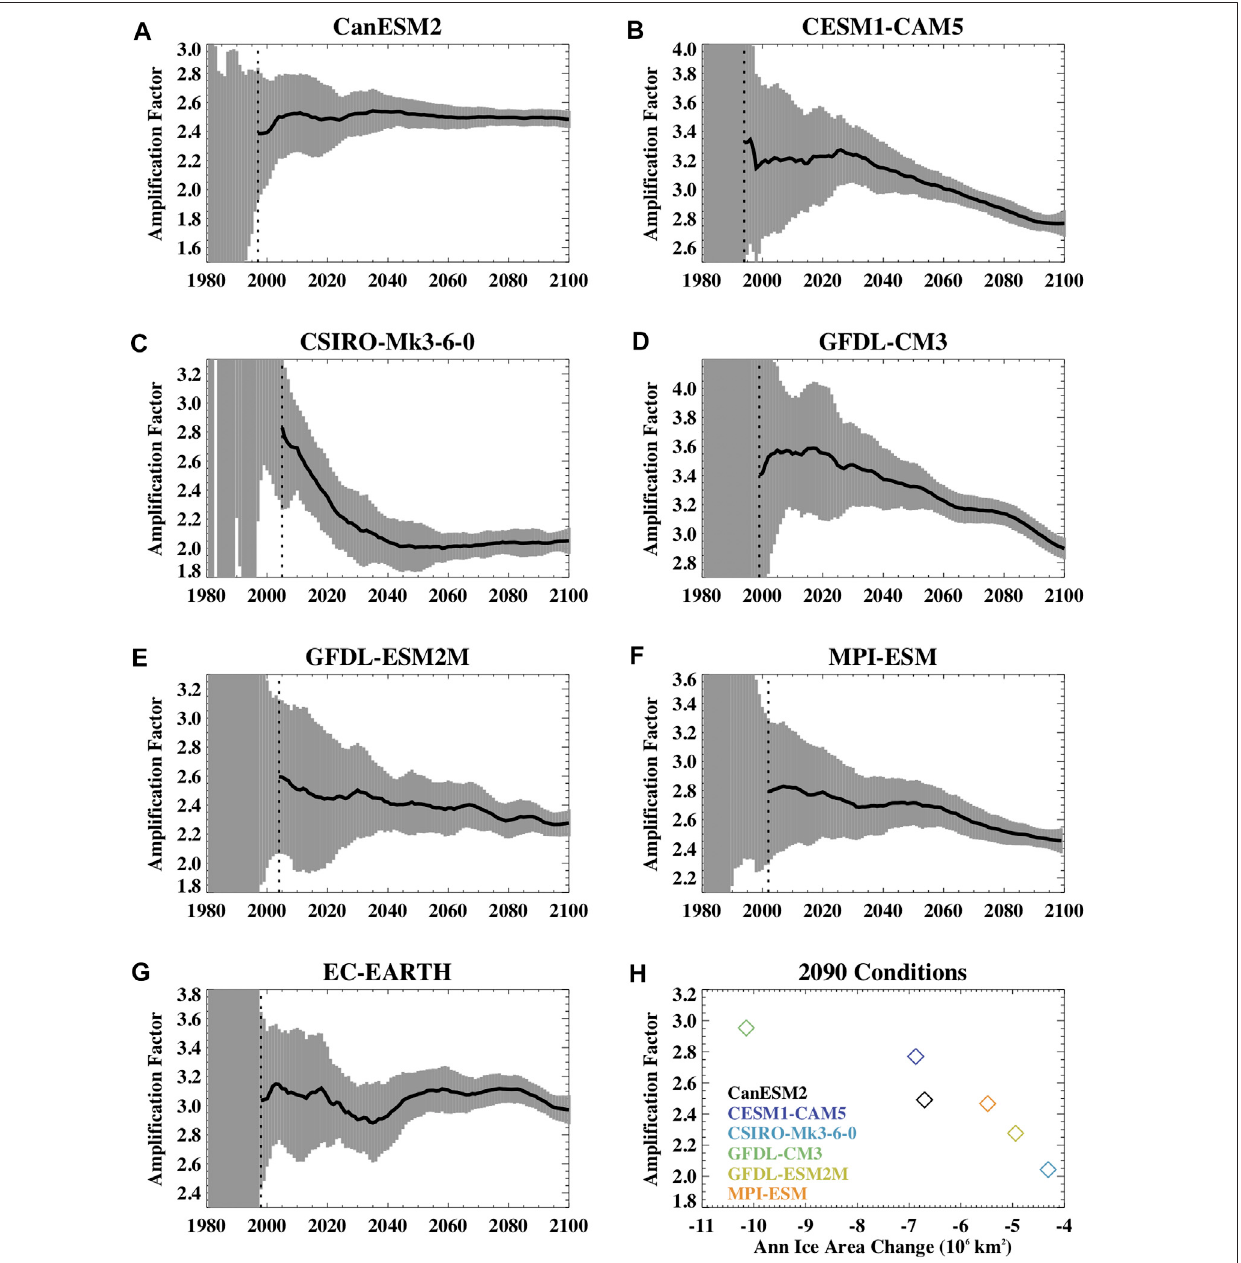
FIGURE6| The1980 – 2100timeseriesoftheArcticampli fi cationfactor fordifferentSMILEScomputed fromannualmeantemperature including for (A) CanESM2, (B) CESM1-CAM5, (C) CSIRO-Mk-3-6-0, (D) GFDL-CM3, (E) GFDL-ESM2M, (F) MPI-ESM,and (G) EC-EARTH.Theblacklineshowstheensemblemeanampli fi cation factor and the grey shading shows the standard deviation across the ensemble members. The dashed vertical line is the time of emergence. Note that the y -axis values aredifferentacrossthedifferentpanelstobetterillustratethechangeswithinamodelovertimebutallpanelshavethesame y -axisrangeof1.5.Panel (H) showsthe average 2090s Ampli fi cation Factor as a function of the annual sea ice area loss across the models (except for EC-EARTH for which no sea ice data was available).